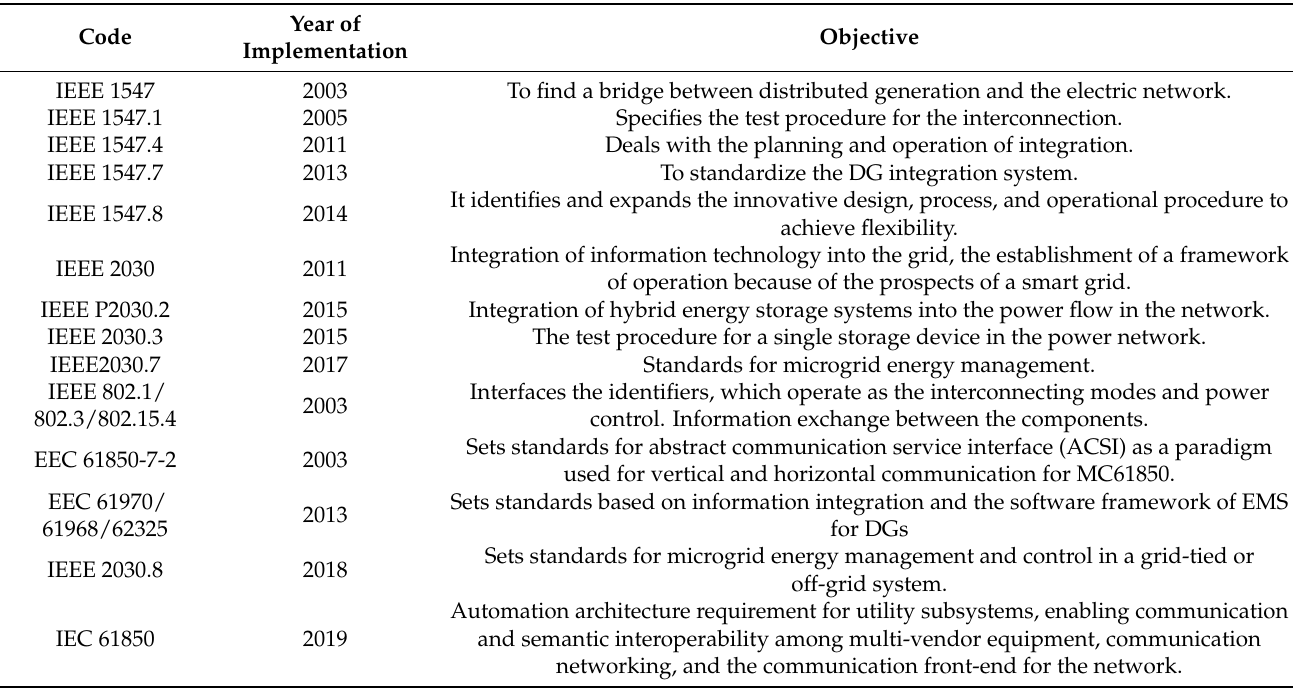
Table 2. Standards used for communication in DSM using DGs and